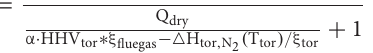
recycling non-condensable torgas or combustion flue gases as the carrying gases.